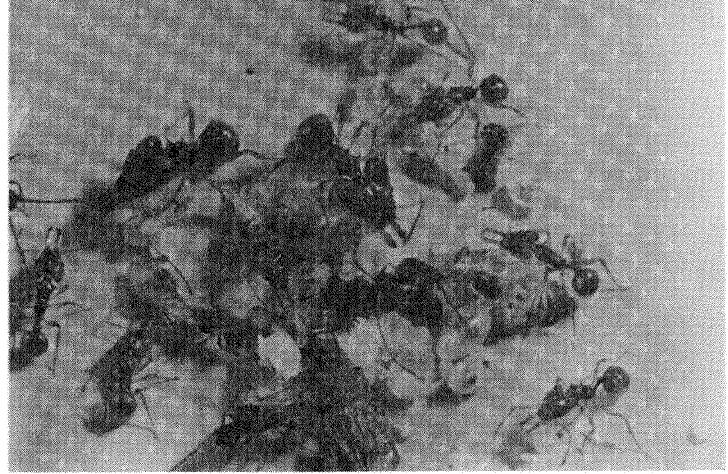
Fig. 1. Part of the colony of Orectognathus versicolor, the three worker castes (minors, medias, majors), males, and different developmental